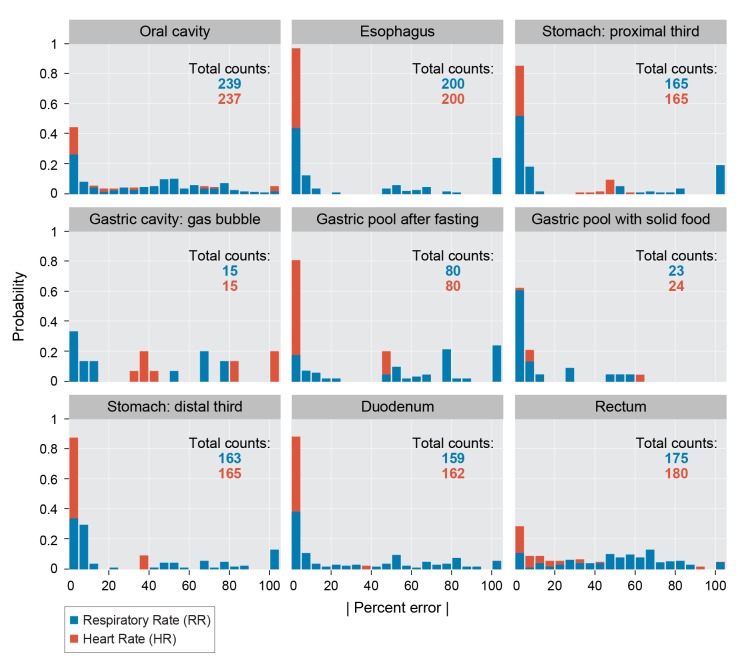
HR and RR estimation performance histograms for all data collected as a function of anatomical location.The x-axis represents the absolute value of the percent error in a given 20s frame; the y-axis is the number of such frames normalized by the “Total Counts” (for each location and vital sign) used to build the histogram. The AMDF valley-finding algorithm can trigger upon higher-order harmonics of the fundamental period, on noise, or on the incompletely removed heart rate period, giving percent errors concentrated at 50% and 100%; these errors can be easily addressed with more sophisticated AMDF algorithms or running median filters (see Discussion).